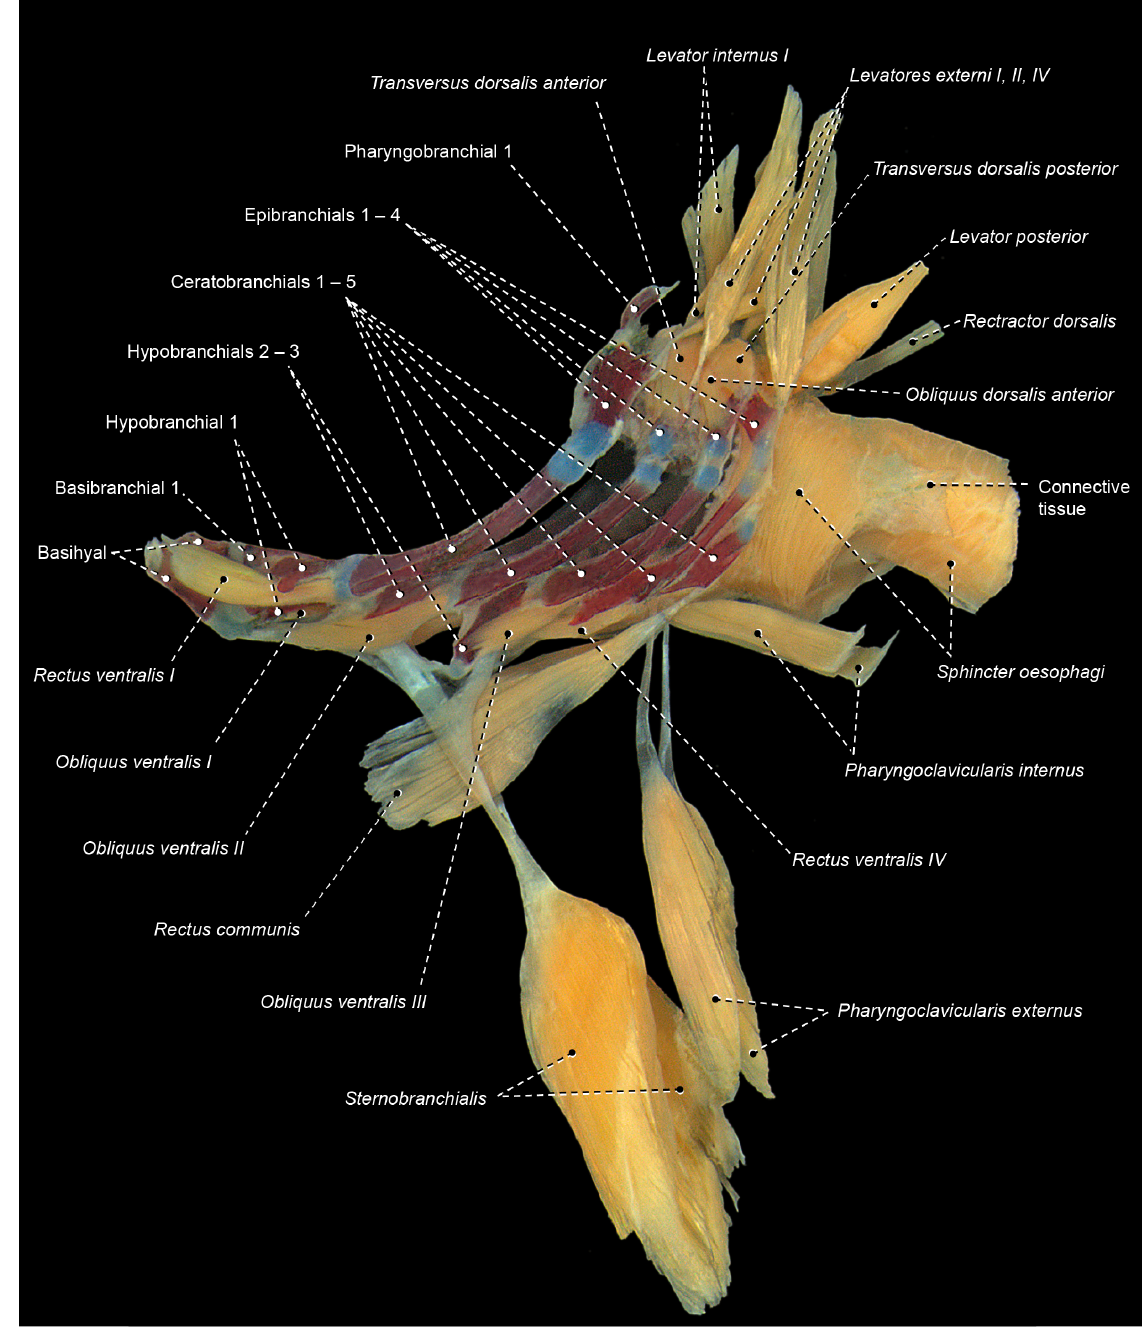
Figure 13. Branchial musculoskeletal system of Antigoniacapros (Caproiformes: Caproidae). MZUSP 108164. Left lateral view; gill rakers removed. Anterior portion of basihyal accidentally cut.